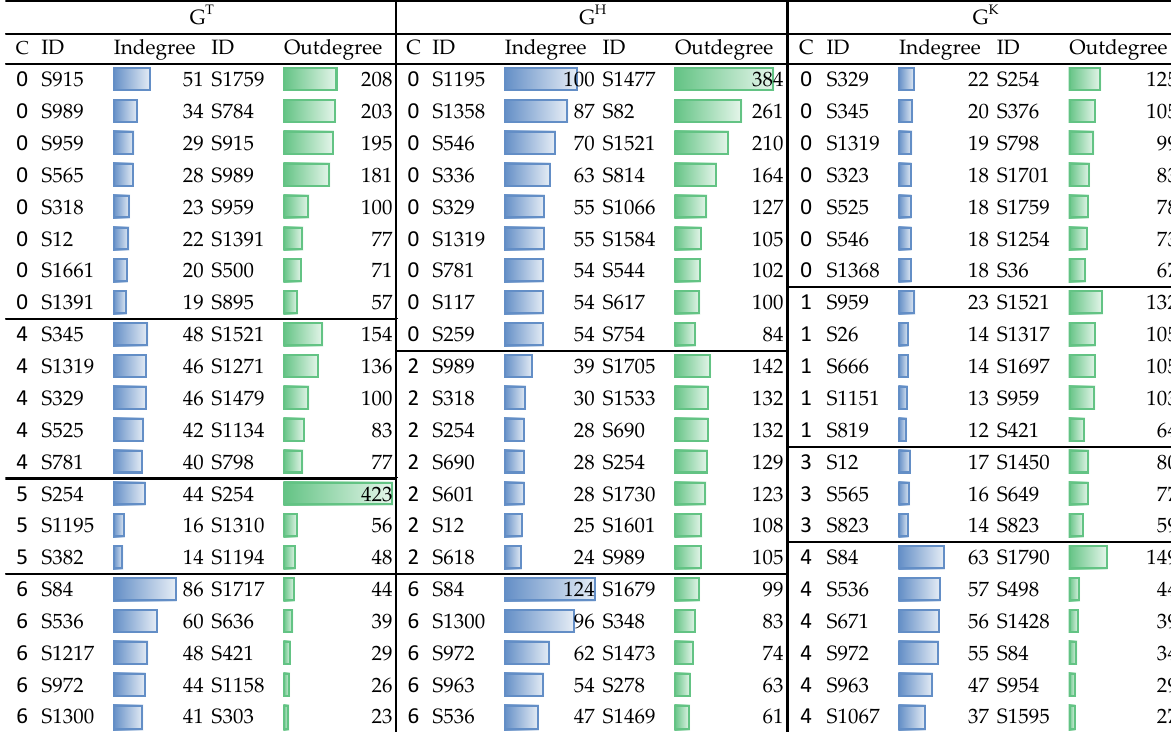
Figure 7. Top opinion leaders of each community of the